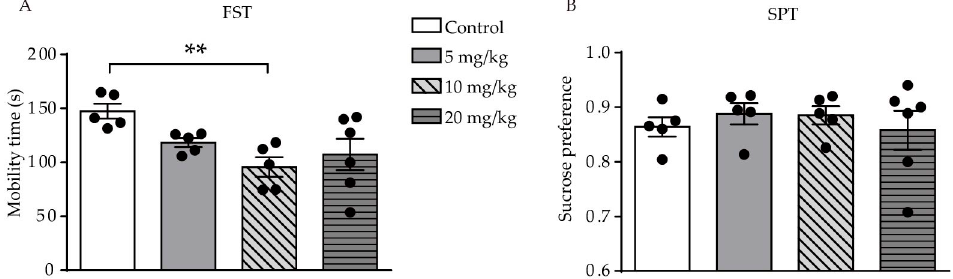
Figure 2. Effects of different doses of ATRA on depression-like behavior and anhedonia level in mice. ( A ) Mobility time in the FST. ( B ) result of the SPT in ATRA and control groups. Data are expressed as mean ± SEM, with n = 5–6 in each group. ** p < 0.01 versus controls, using one way ANOVAs with LSD test.